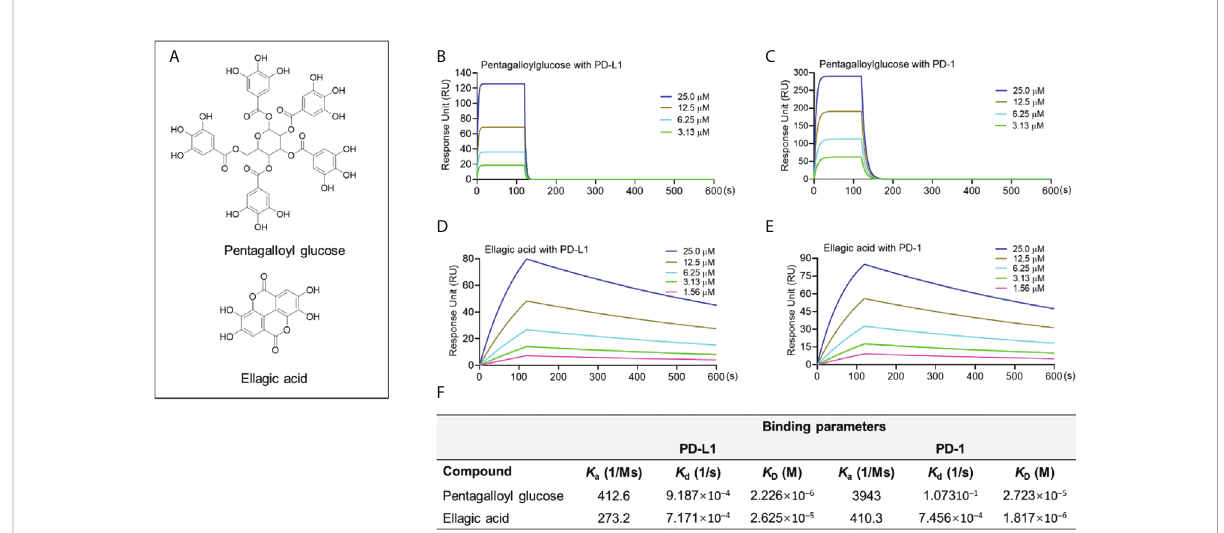
FIGURE 4 Chemical structure of PGG and EA (A) . Binding pro fi le of natural compounds at various concentrations with PD-1 and PD-L1 proteins characterized by the SPR measurements. Sensograms of PGG with PD-L1 (B) or PD-1 protein (C) at 3.13-25 m M. Sensograms of EA with PD-L1 (D) and PD-1 (E) protein at 1.56-25 m M. Summarized binding parameters including Ka, Kd, and K D between test compounds and PD-L1 and PD-1 proteins (F)